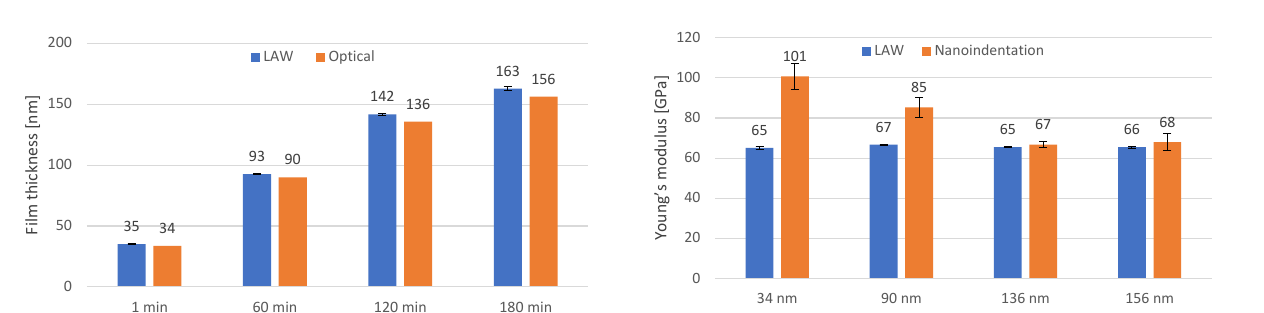
Figure 3. Film thickness of samples from dry thermal growth measured by LAW compared to results from optical method.